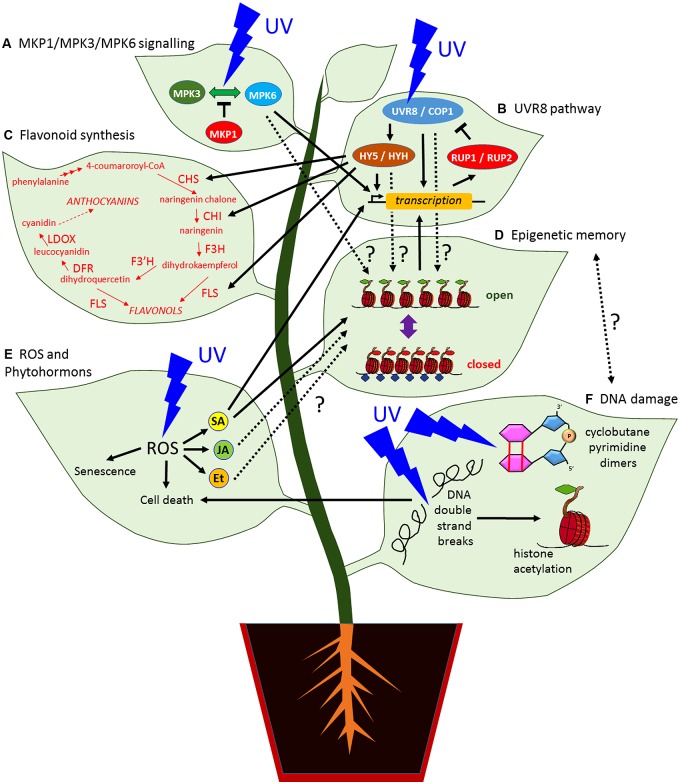
Simplified model showing the UV radiation signaling pathways in plants and their possible links to an epigenetic based memory. (A) The MAP kinase MPK3 and MPK6 signaling pathway can be activated by UV stress whereas MKP1 suppresses the activation. (B) UVR8 signaling pathway, the dimerization of the UV photoreceptor UVR8 with COP1 upregulates the expression of UV targets genes including HY5 and HYH which activate further UV response genes. In turn, the expression of RUP1 and RUP2 establish a negative feedback loop by direct protein binding. (C) HY5 can upregulate the expression of enzymes involved in flavonoid and anthocyanin biosynthesis. (D) Change of antagonistic epigenetic marks to light and UV stress could be part of an epigenetic memory but it remains unclear whether the activation of the MKP1/MPK3/MPK6 (A) or the UVR8 signaling pathway (B) by UV can establish persistent chromatin modifications. The phytohormone SA (E) can prime response genes by setting H3K4me3 at their loci that increase the transcriptional response (B) by a second stress. (E) UV-B promotes the accumulation of ROS that induces the production of phytohormones including SA, JA, and Et. High ROS concentration cause senescence and cell death. (F) UV radiation can cause cyclobutane pyrimidine dimers and DNA double strand breaks that can trigger cell death (E). DNA damage repair pathways involve chromatin modifications including histone acetylation and remodeling to correct UV induced DNA lesions. There is a potential link between DNA repairs (F) and epigenetic memory (D). CHI, CHALCONE ISOMERASE; CHS, CHALCONE SYNTHASE;; COP1, CONSTITUTIVELY PHOTOMORPHOGENIC 1; DFR, DIHYDROFLAVONOL 4-REDUCTASE; Et., ethylene; F3H, FLAVANONE 3-HYDROXYLASE; F3′H, FLAVONOID 3′-HYDROXYLASE; FLS, FLAVONOL SYNTHASE; HY5, ELONGATED HYPOCOTYL 5; HYH, HY5 HOMOLOG; JA, jasmonate; LDOX, LEUCOANTHOCYANIDIN DIOXYGENASE; MKP1, MAP KINASE PHOSPHATASE 1; MPK3 and MPK6, MITOGEN-ACTIVATED PROTEIN KINASES 3 and 6, ROS, reactive oxygen species; RUP1 and RUP2, REPRESSOR OF UV-B PHOTOMORPHOGENESIS 1 and 2; SA, salicylic acid; UV, ultraviolet radiation; UVR8, UV RESISTANCE LOCUS 8.